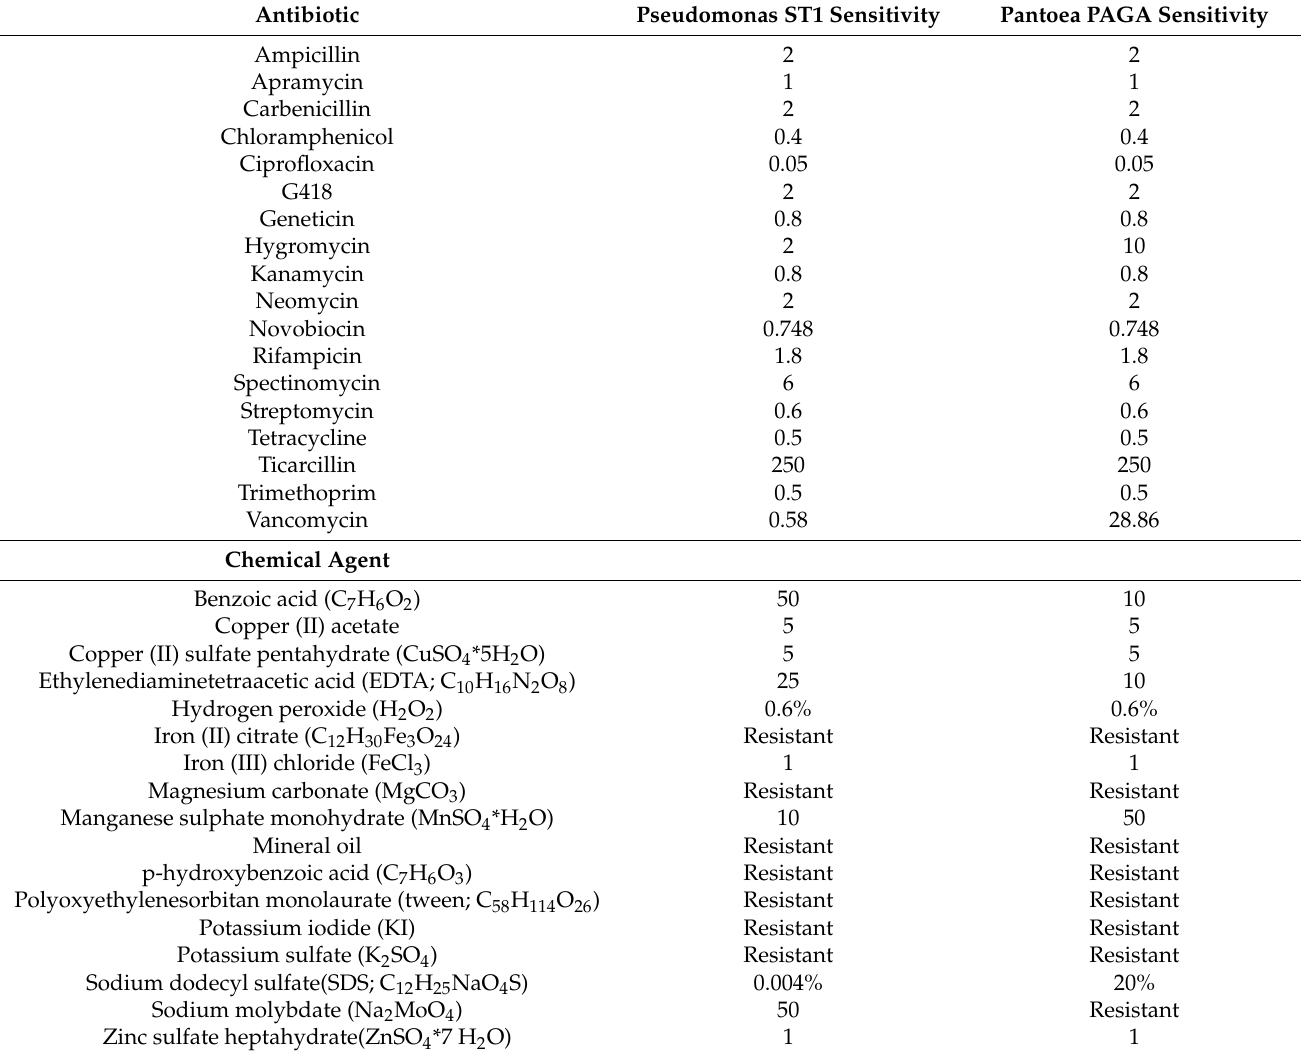
Table 2. In vitro antibacterial activity of the antibiotics and chemical agents tested against Pseudomonas ST1 and Pantoea paga strains. Tested concentrations are shown in mg/mL or percentage (%). Antibiotic Pseudomonas ST1